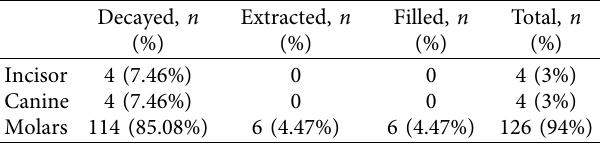
Table 4: Distribution of dental caries, extraction, or filling among primary teeth.